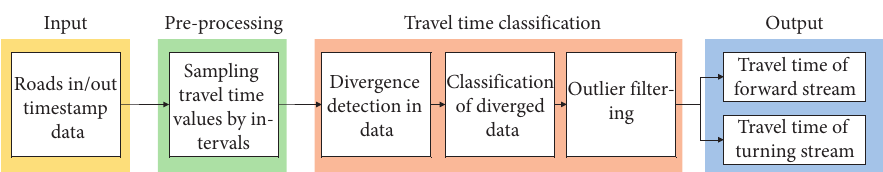
Figure 3: Framework for travel time estimation of diverging traffic